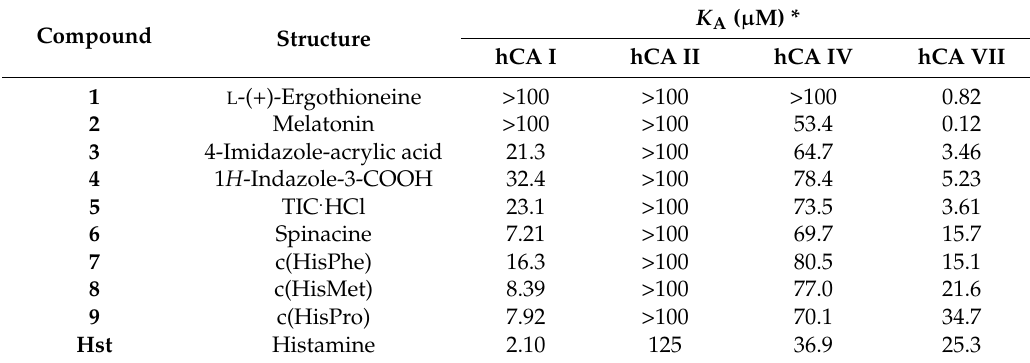
* Mean from three different determinations (errors in the range of 5–10% of the reported values, data not